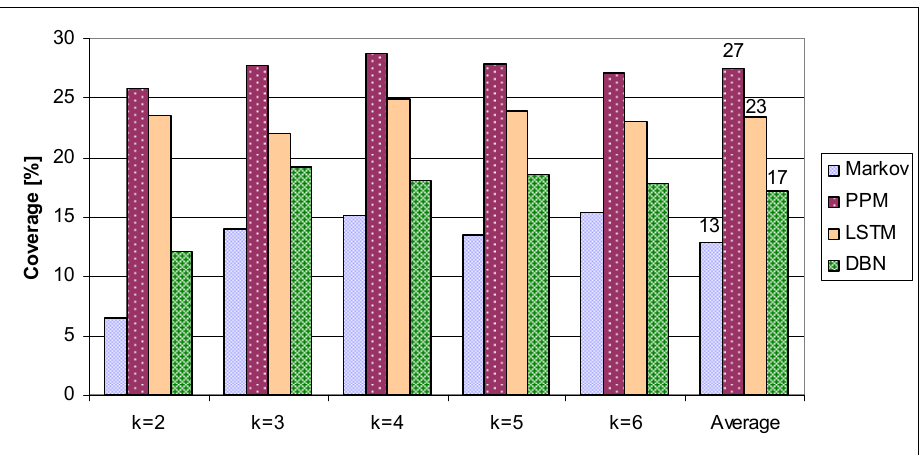
Figure 12. Coverage with the mood variable trough k ‐ fold validation.